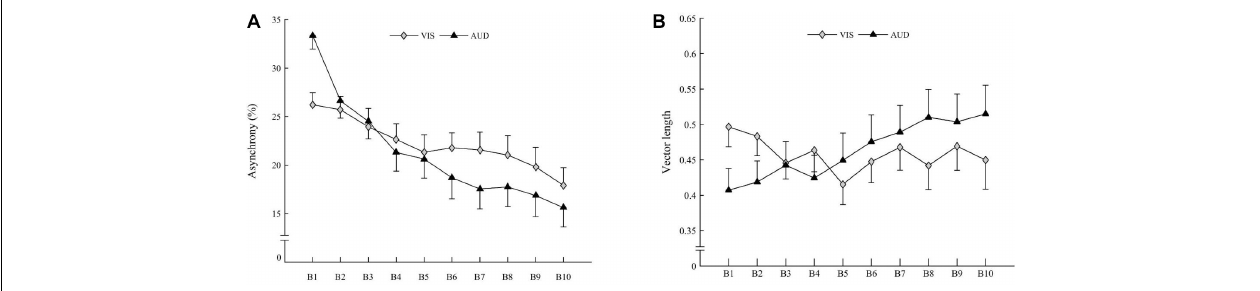
FIGURE 4 | (A) Mean asynchrony of children (both groups averaged) for visual modality (gray diamonds) and auditory modality (black triangles). (B) Mean vector length of children (both groups averaged) for visual modality (gray diamonds) and auditory modality (black triangles). Vertical bars represent inter-individual variability (standard